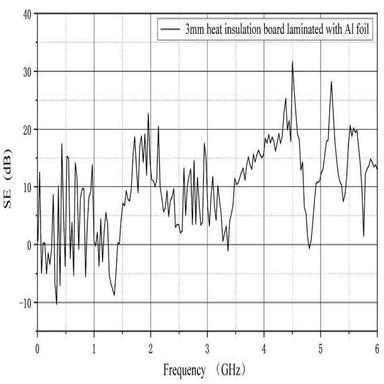
SE test of a 3 mm heat insulation board laminated with aluminum foil. Fig. 13. Comparison of SE for heat insulation board samples with or without laminated aluminum foil.